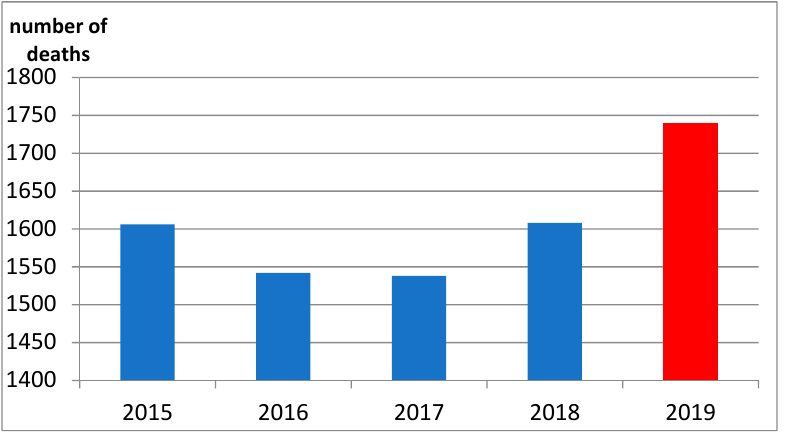
Figure 8. Number of deaths in the Kuyavian-Pomeranian Voivodeship in June 2015–2019.